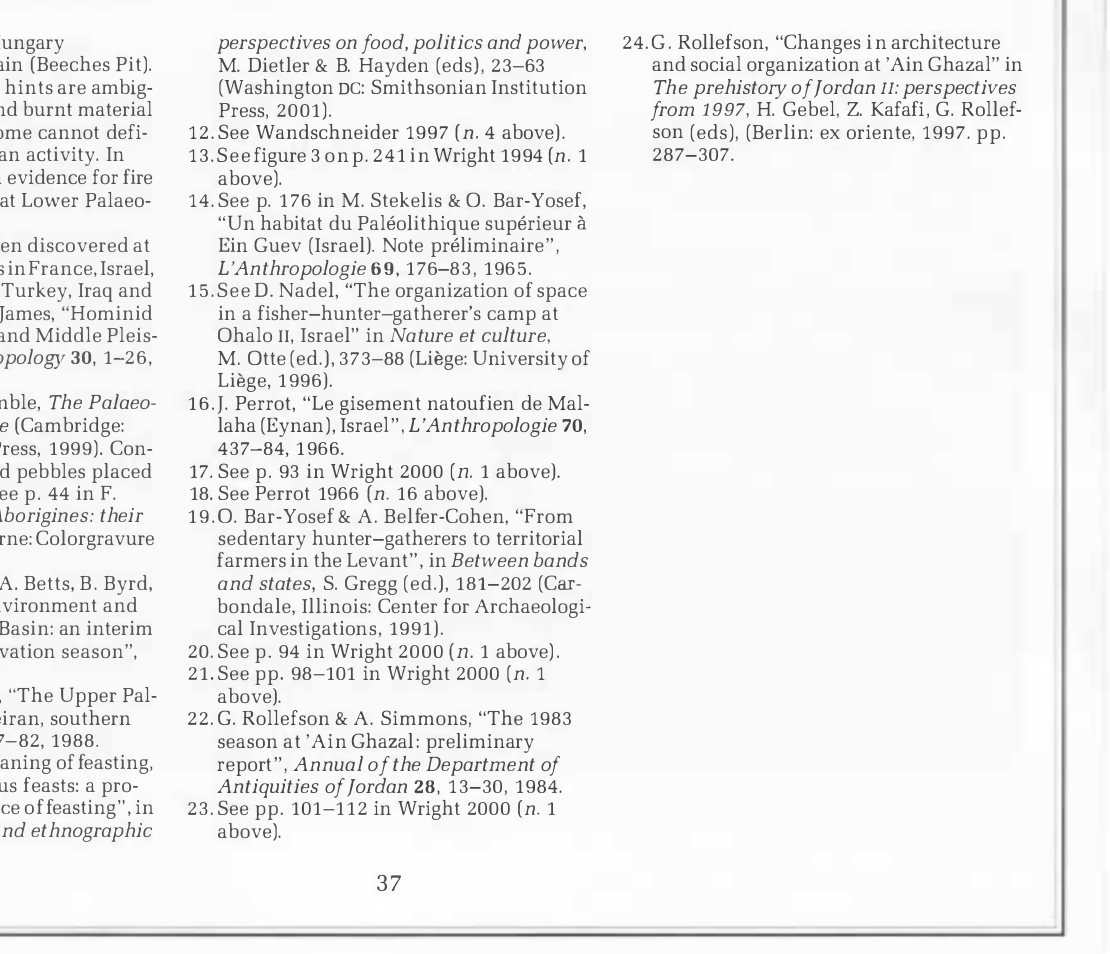
Figure 7 PPNB stone vessels. Limestone platters and bowls, including (central section) a grinding bowl with a disc-shape hand stone. For further information on sources seep. 106 in Wright 2000 (n. 1).